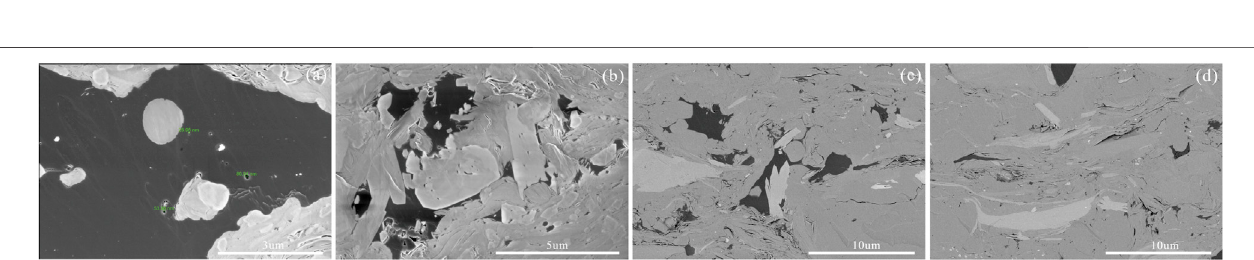
Frontiers in Earth Science |